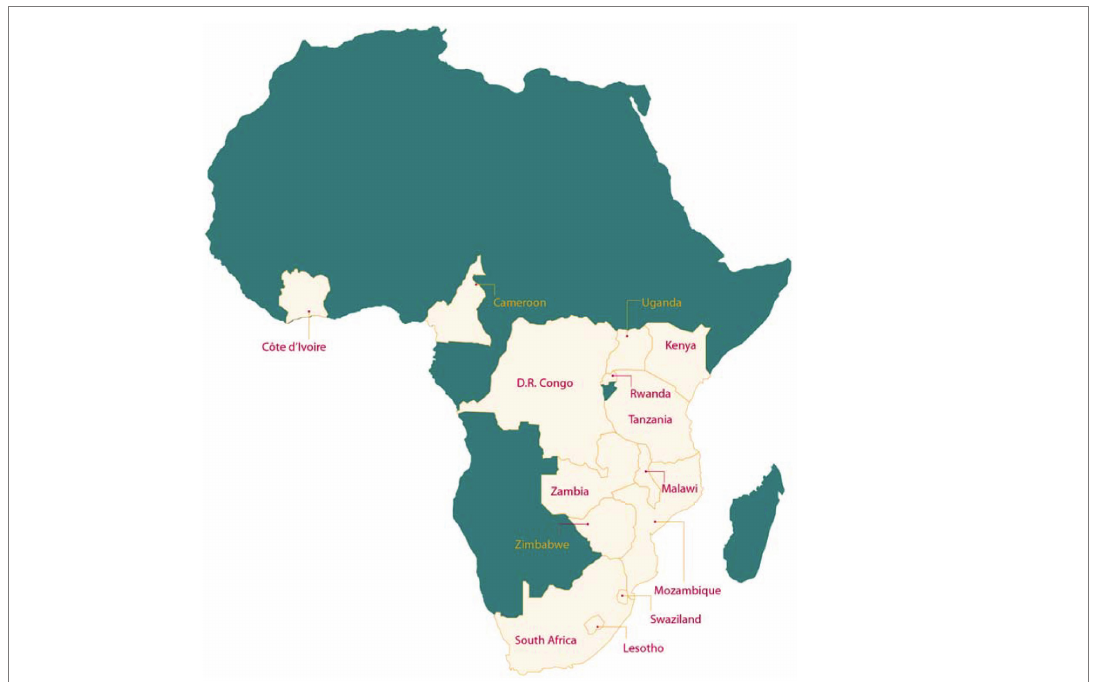
Figure 3. Countries where EGPAF Works in Sub-Saharan